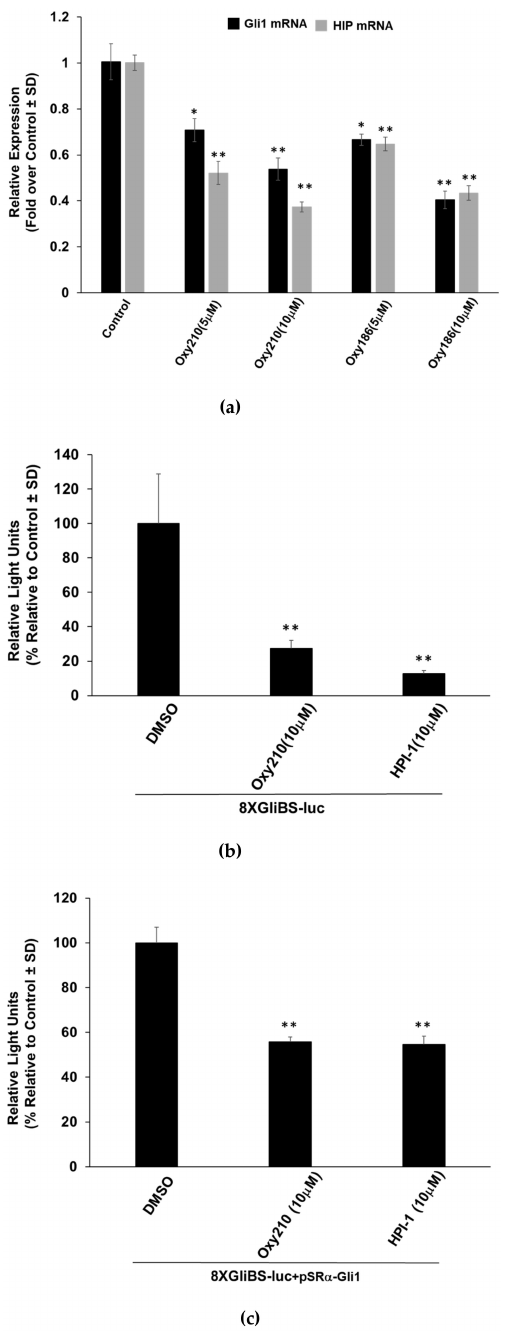
Figure 5. Oxy210 acts downstream of Smo. ( a ) Sufu- / - MEF cells were treated with DMEM containing 5% FBS in the presence or absence of Oxy210. After 72 h, RNA was extracted and analyzed by Q-RT-PCR for the expression of Hh target genes Gli1 and Hip, normalized to Oaz1 expression. ( b ) Sufu- / - cells cultured in 24 well-plate were transfected with a Gli response-element reporter (pGL3b-8xGliBS-Luciferase) plasmid and a pSV40-Renilla-Luciferase plasmid. 6 hrs after transfection, cells were treated with the compounds as indicated for 72 hrs. Luciferase activity was measured and normalized to the Renilla luciferase activity. ( c ) NIH3T3 cells cultured in 24 well-plate were transfected with a Gli response-element reporter (pGL3b-8xGliBS-Luciferase) plasmid, a pSV40-Renilla-Luciferase plasmid and a vector expressing Gli1, pSRa-Gli1. 6 h after transfection, cells were treated with the test agents as indicated for 72 hrs. Data from a representative experiment are reported as the mean of triplicate determinations ± SD (* p < 0.05 vs. DMSO or control; ** p < 0.01 vs. DMSO or